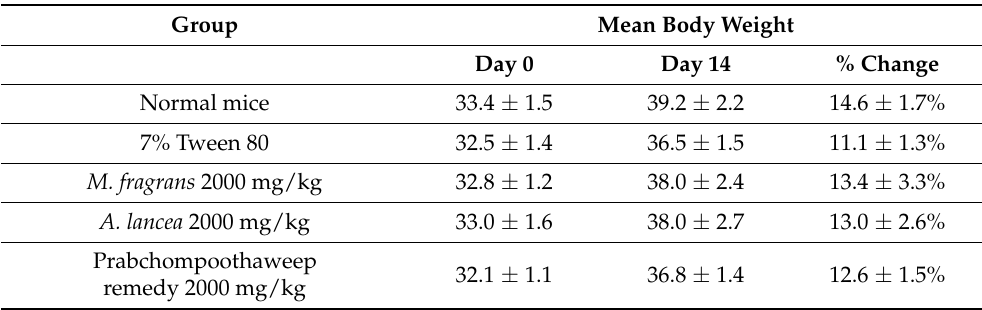
Table 8. Effect of ethanolic extracts of M. fragrans , A. lancea , and Prabchompoothaweep remedy on body weight changes in the acute toxicity test on day 0 and day 14 after